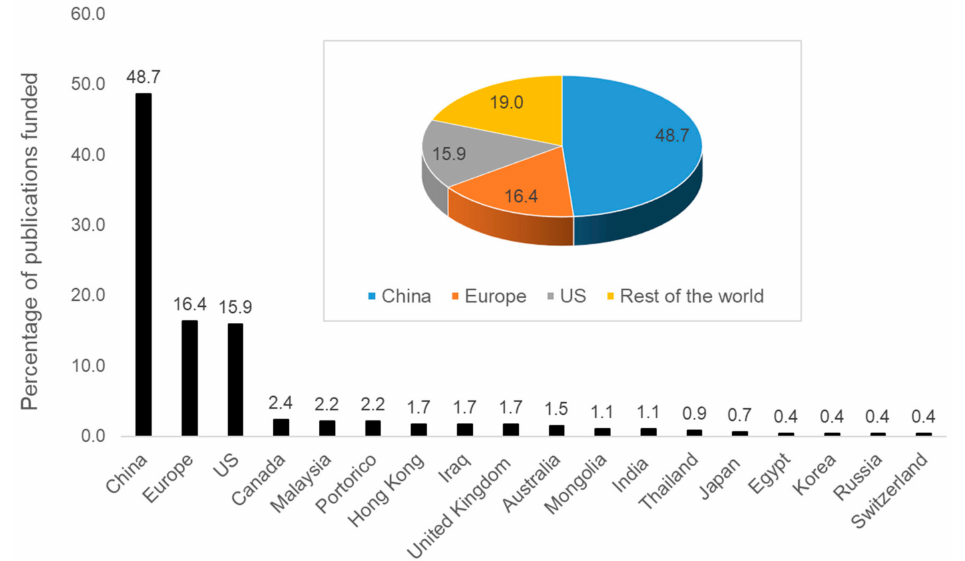
Figure 4. Percentage of publications funded per